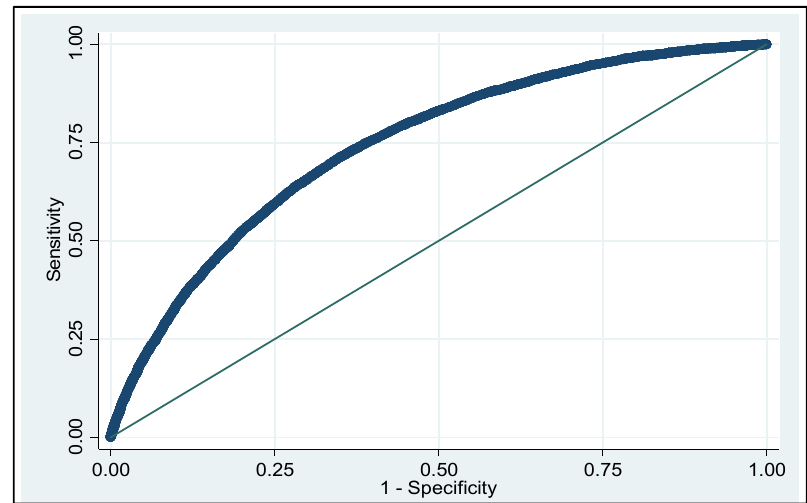
Figure 2. ROC curve of the mortality predictor model applied to the training cohort. AUC 0.742, 95% CI: 0.737–0.747.